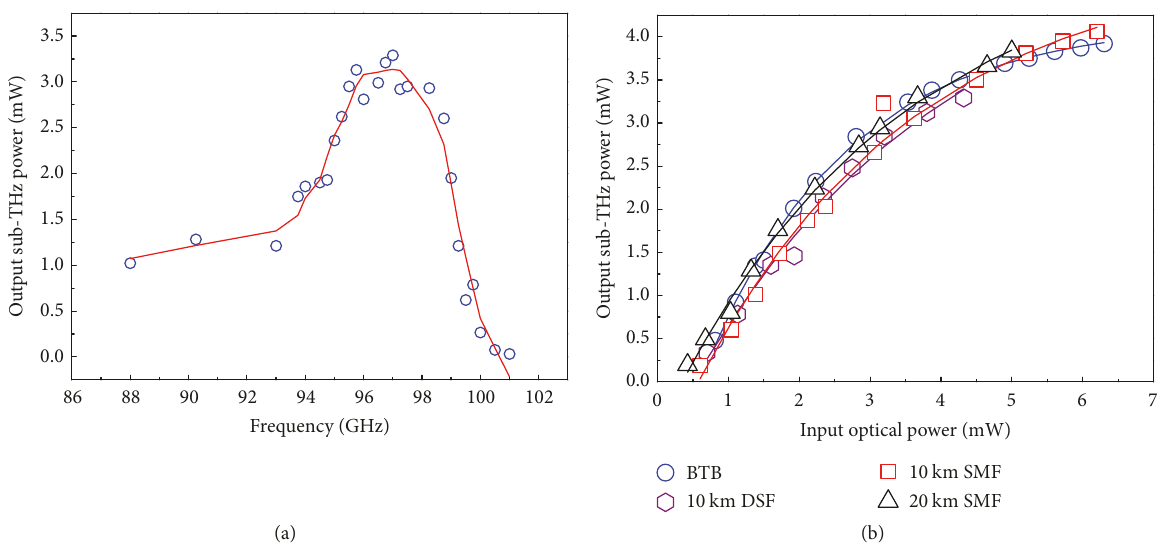
Figure 3: Dependence of sub-THz wave radiation power (a) on different wavelength spacing with input optical power at 3.6 mW and (b) on